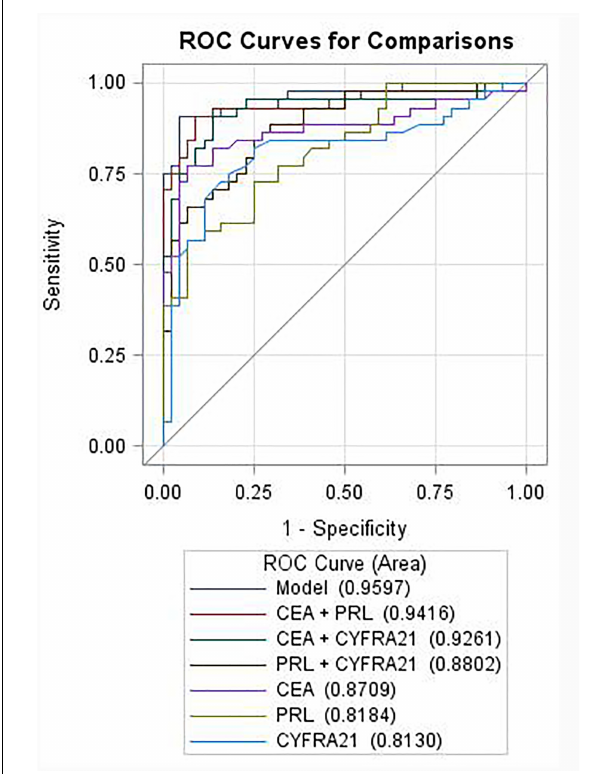
FIGURE 2 | Receiver operating characteristic curves of individual or combination of PRL, CEA, and CYFRA21 serum tumor biomarkers in differentiating NSCLC from the healthy controls.